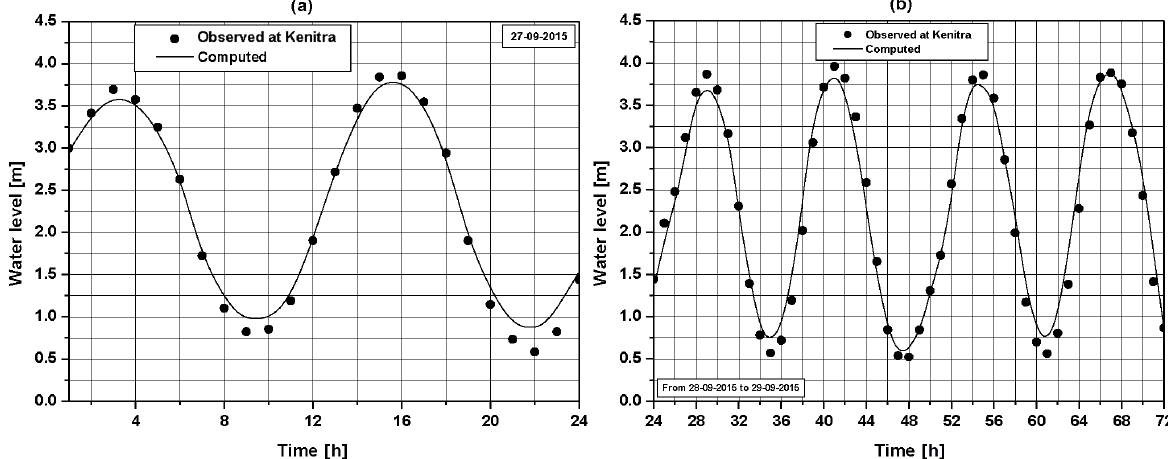
developed by Savenije (1993a, 2012) and revised by Gisen et al. (2015b) are appropriate to be applied in getting a first